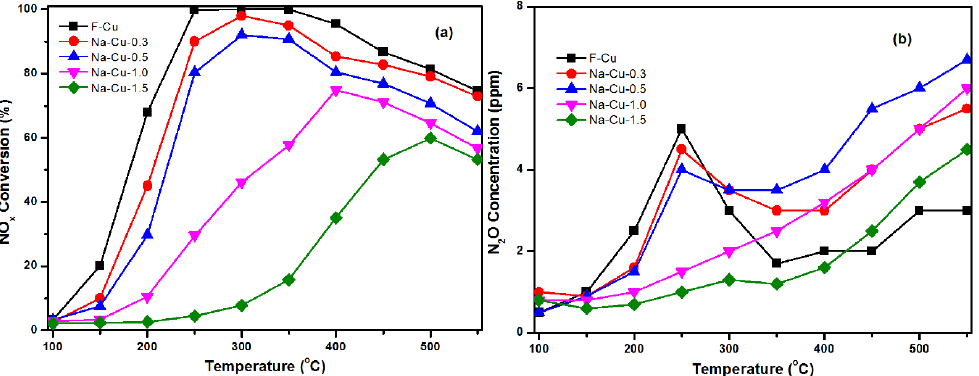
Figure 8. ( a ) NOx conversion as a function of reaction temperature over catalysts; ( b ) N 2 O formation during NH 3 -SCR reaction on the catalysts ( b ). The reaction was carried out with a feed containing 500